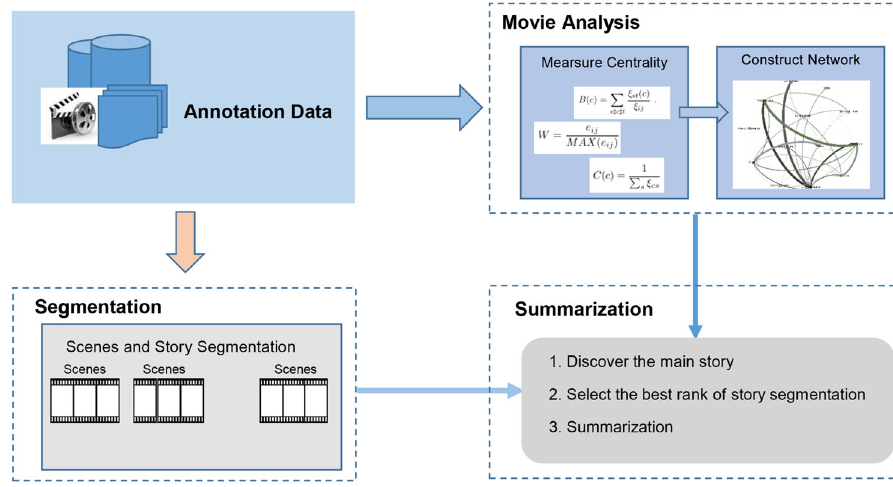
Fig. 2 The framework of proposed